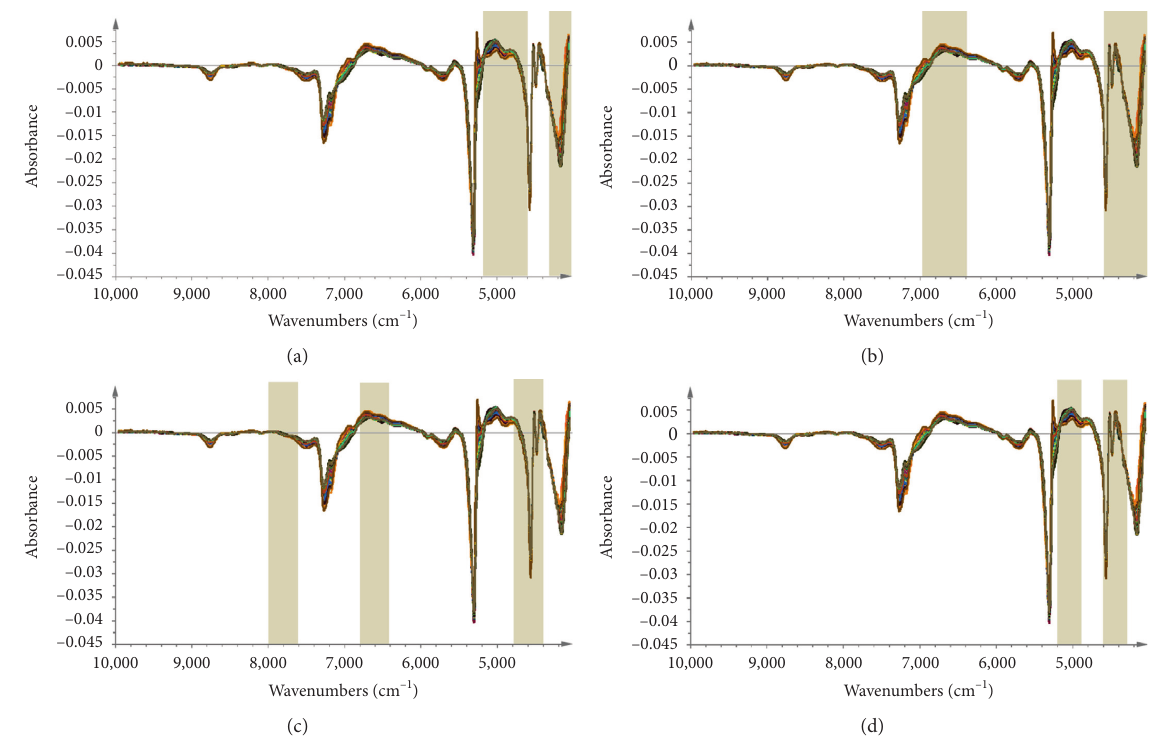
Figure 3: The efficient spectral intervals selected by si-PLS for the prediction of four phenolic compounds: (a) gastrodin, (b) p - hydroxybenzyl alcohol, (c) parishin B, and (d) parishin A.